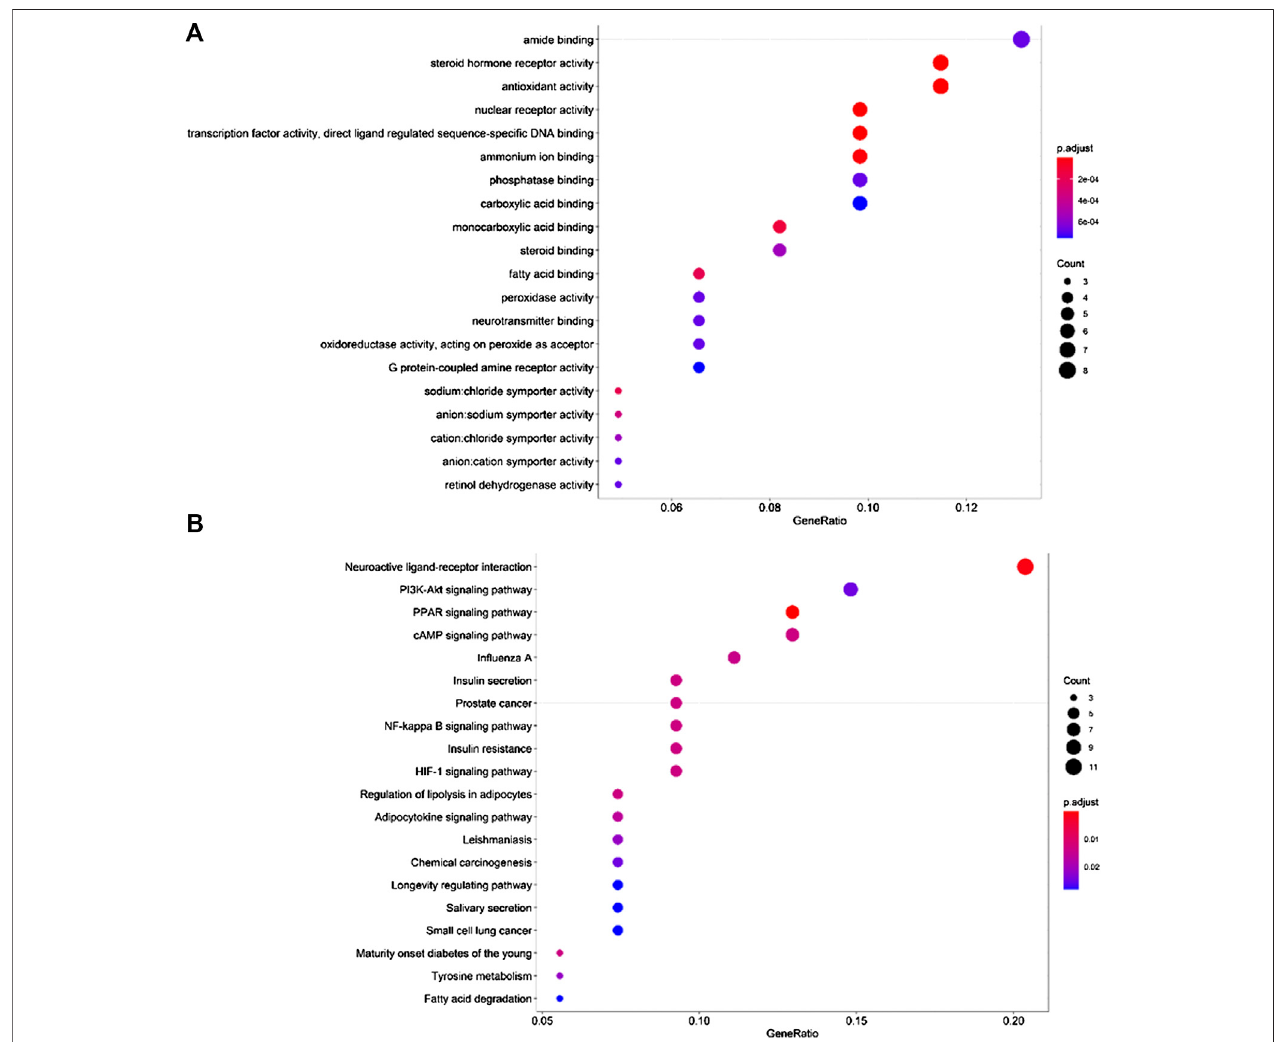
FIGURE 5 | Top 20 GO terms and KEGG pathways. (A) GO biological process analysis, (B) KEGG pathway analysis.